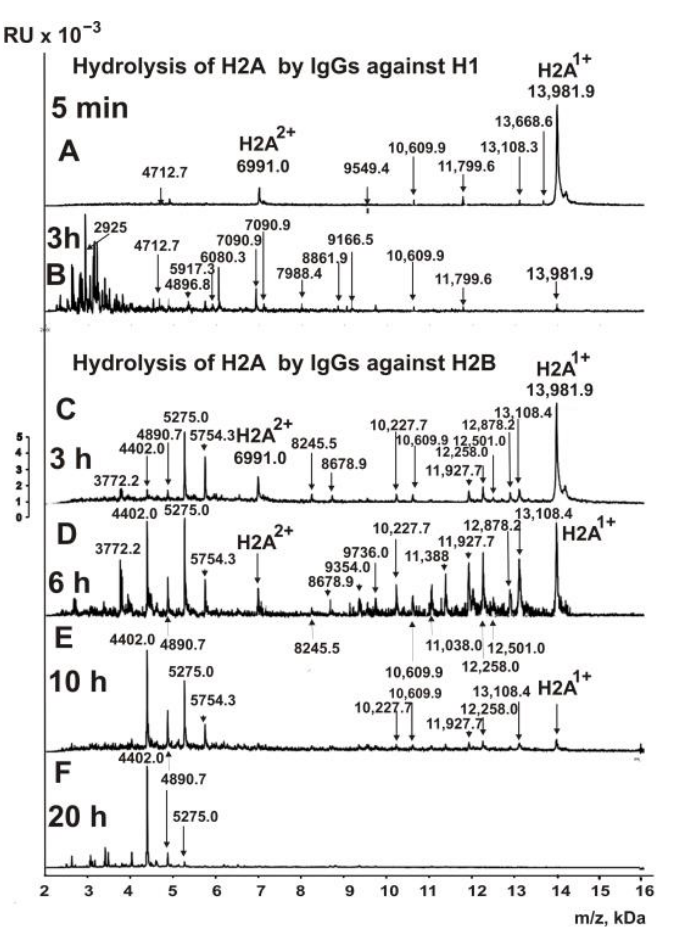
Figure 4. MALDI spectra corresponding to H2A histone (0.8 mg/mL) over time during hydrolysis the presence of IgGs (0.04 mg/mL) against H1 ( A , B ) and H2B ( C – F in the presence of IgGs (0.04 mg/mL) against H1 ( A , B ) and H2B ( C – F ). After 3 h of incubation, H2A was completely hydrolyzed by antibodies against H1